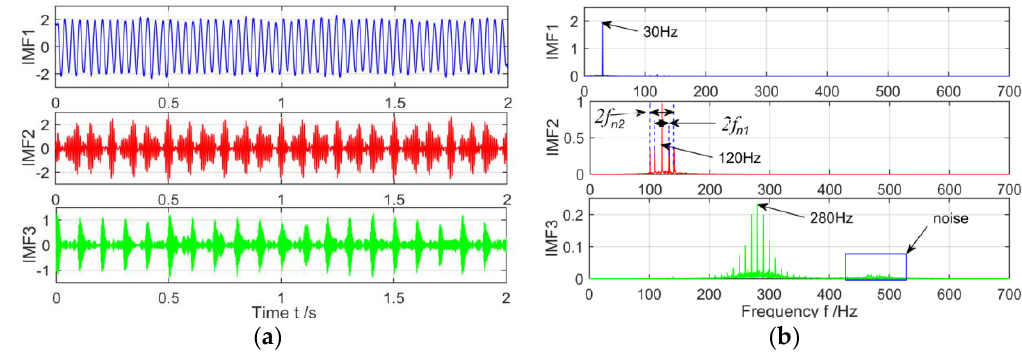
Figure 8. The spectrum of IMFs after MVMD decomposition and its corresponding spectrum. ( a ) Time domain of IMFs after MVMD; and ( b ) The spectrum corresponding to each layer of IMF.